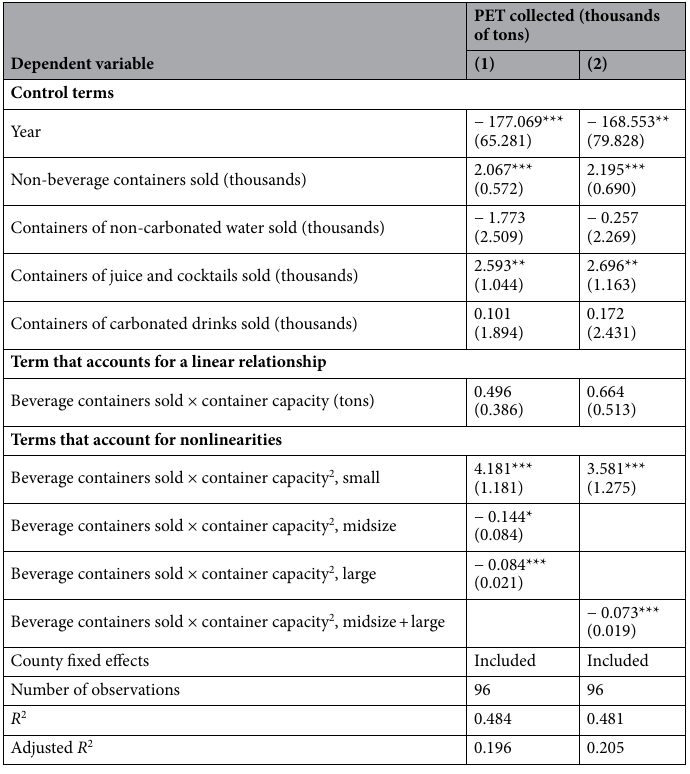
Table 2. Feasible generalized least square estimates of the relationship between product category, bottle capacity, and PET waste collection Numbered columns correspond to different model specifications. Numbers in parentheses are standard errors. * Pr( >|t|) < 0.1; ** Pr ( >|t|) < 0.05; *** Pr ( >|t|) <